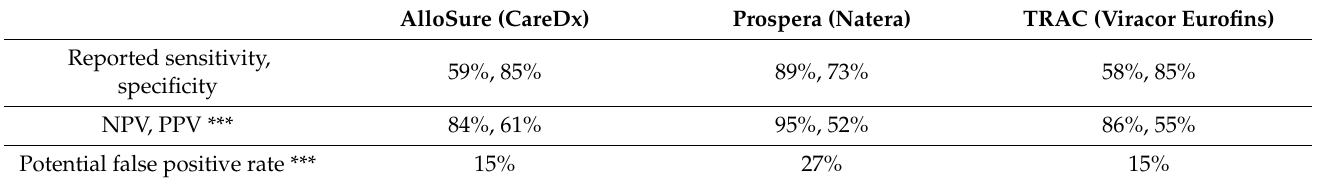
Table 1. Cont. AlloSure